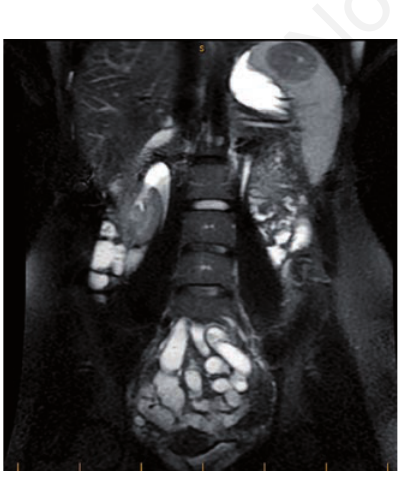
Figure 3. A) Hematoxylin and Eosin stain of splenic tissue demonstrating a lesion with Figure 2. Magnetic resonance imaging of haphazardly arranged fibroblasts with extensive hemorrhage, clusters of mature plasma abdomen demonstrating a hypodense cells, eosinophils and small numbers of lymphocytes. B) Smooth muscle actin stain lesion on the superior pole of the spleen. demonstrating heavy fibroblastic